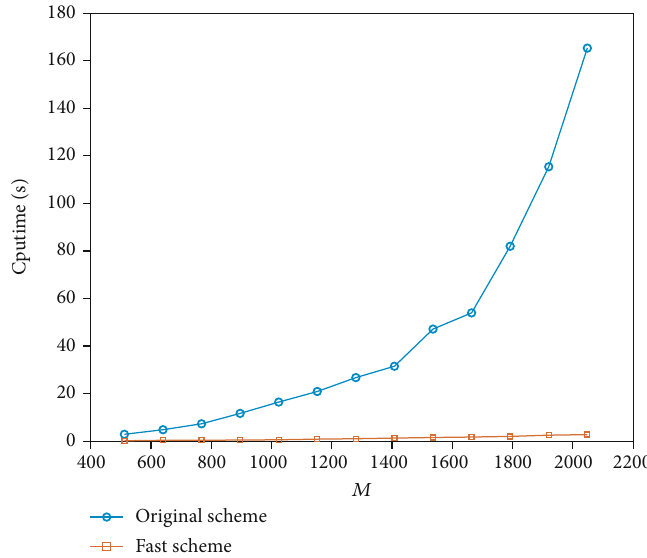
Figure 3: Comparison of CPU execution time between original and fast schemes with fi xed α = 0 : 7 and β = 0 :